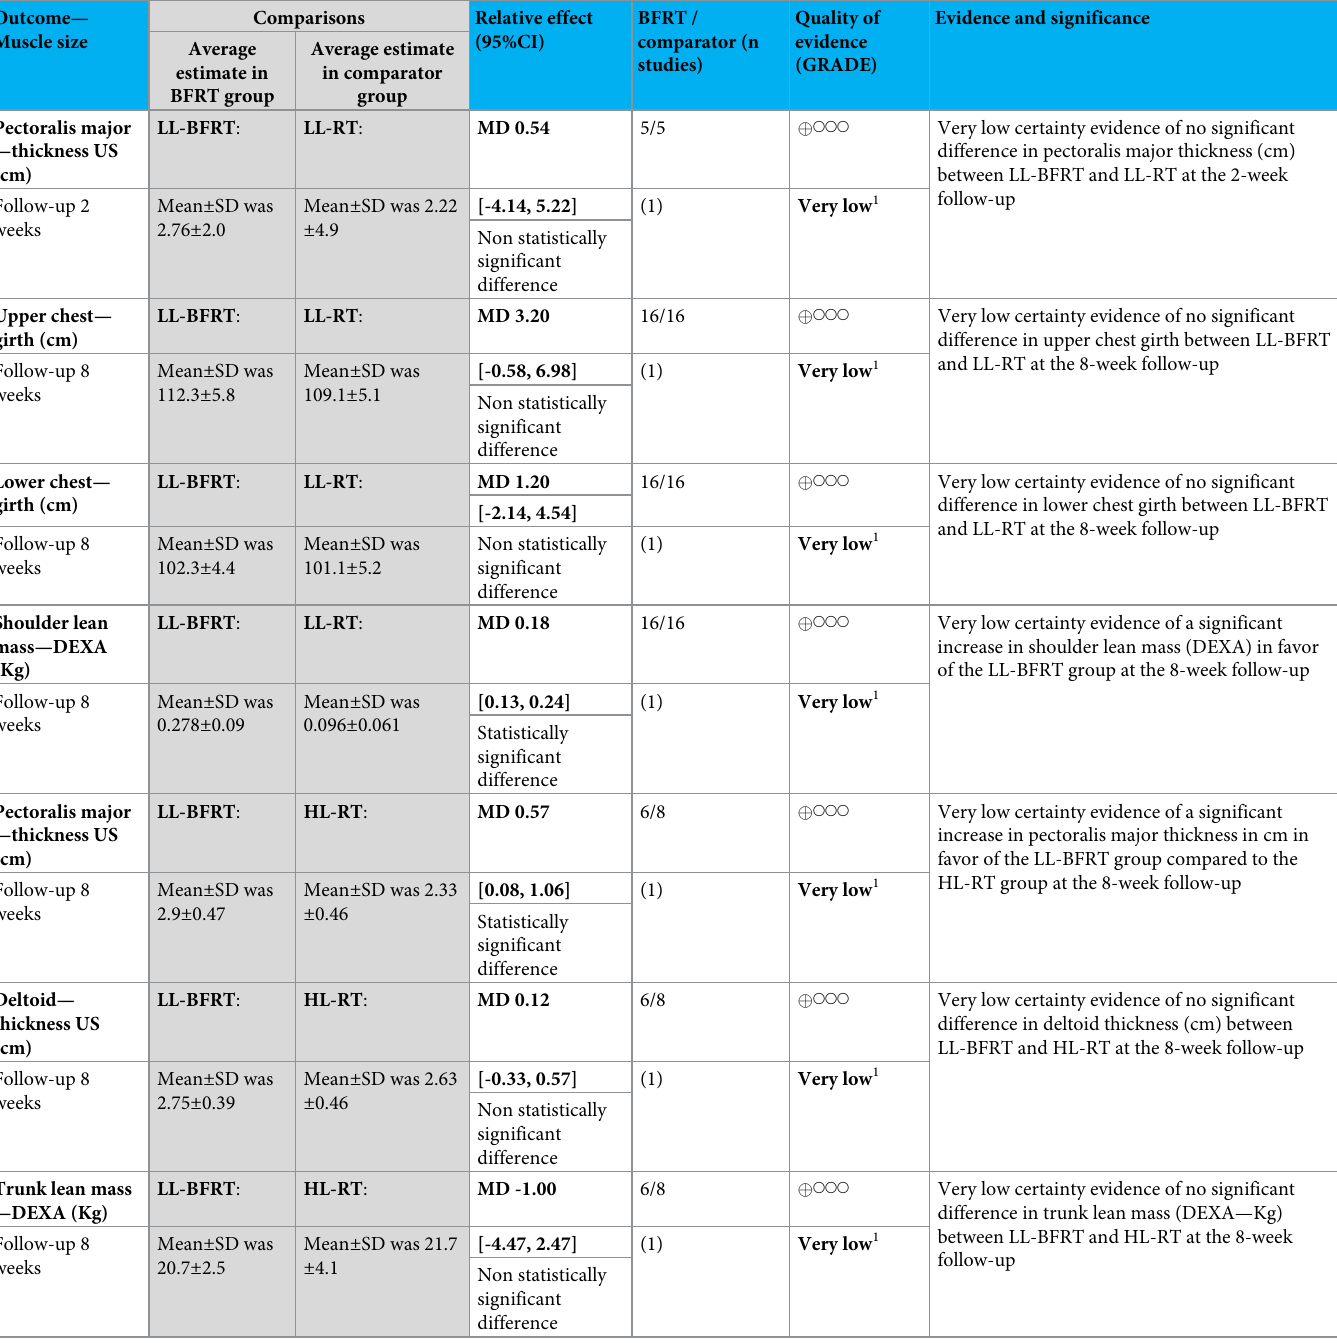
Table 5. Summary of evidence for the effects of LL-BFRT compared with LL-, HL-RT, or no exercise in muscle size. Outcome— Muscle